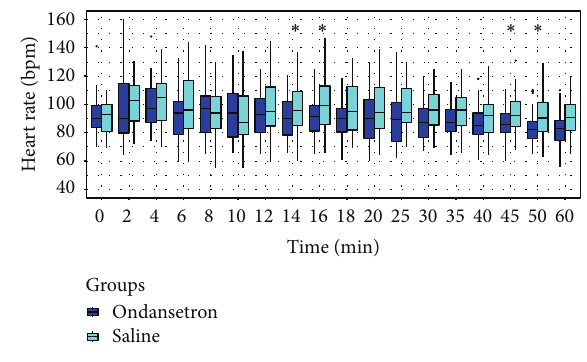
Figure 4: Trends of mean blood pressure (MAP). ∗ < 0.05 . Figure 5: Trends of heart rate (HR). ∗ < 0.05